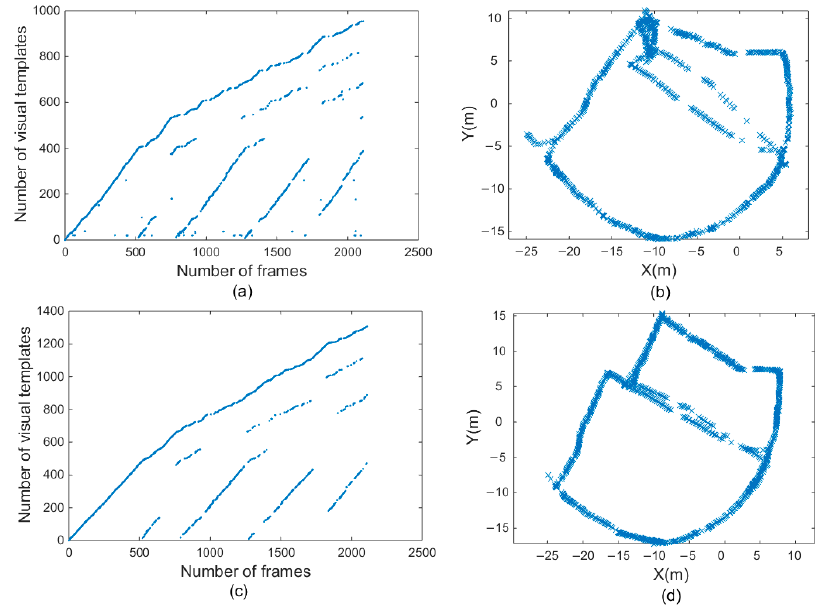
Figure 14. Experimental results of fourth scene. ( a , b ) are visual templates and experience map output by traditional RatSLAM. ( c , d ) are visual templates and experience map output by RatSLAM based on HSI model.